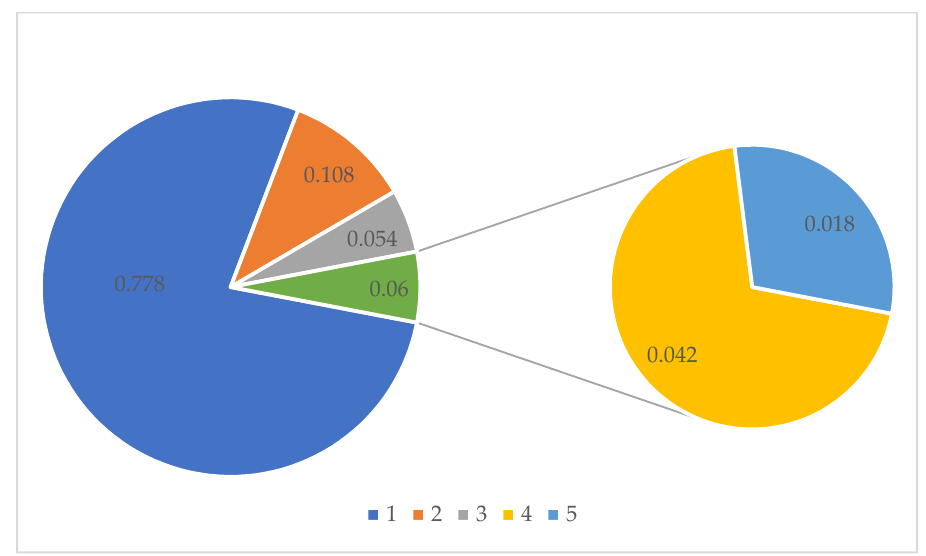
Figure 6. Distribution of different indexes in five cluster centers.